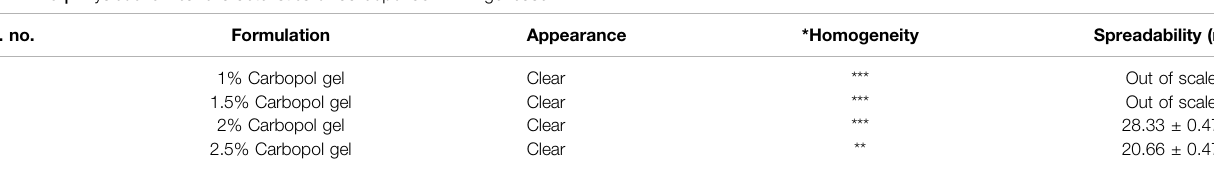
Frontiers in Pharmacology |